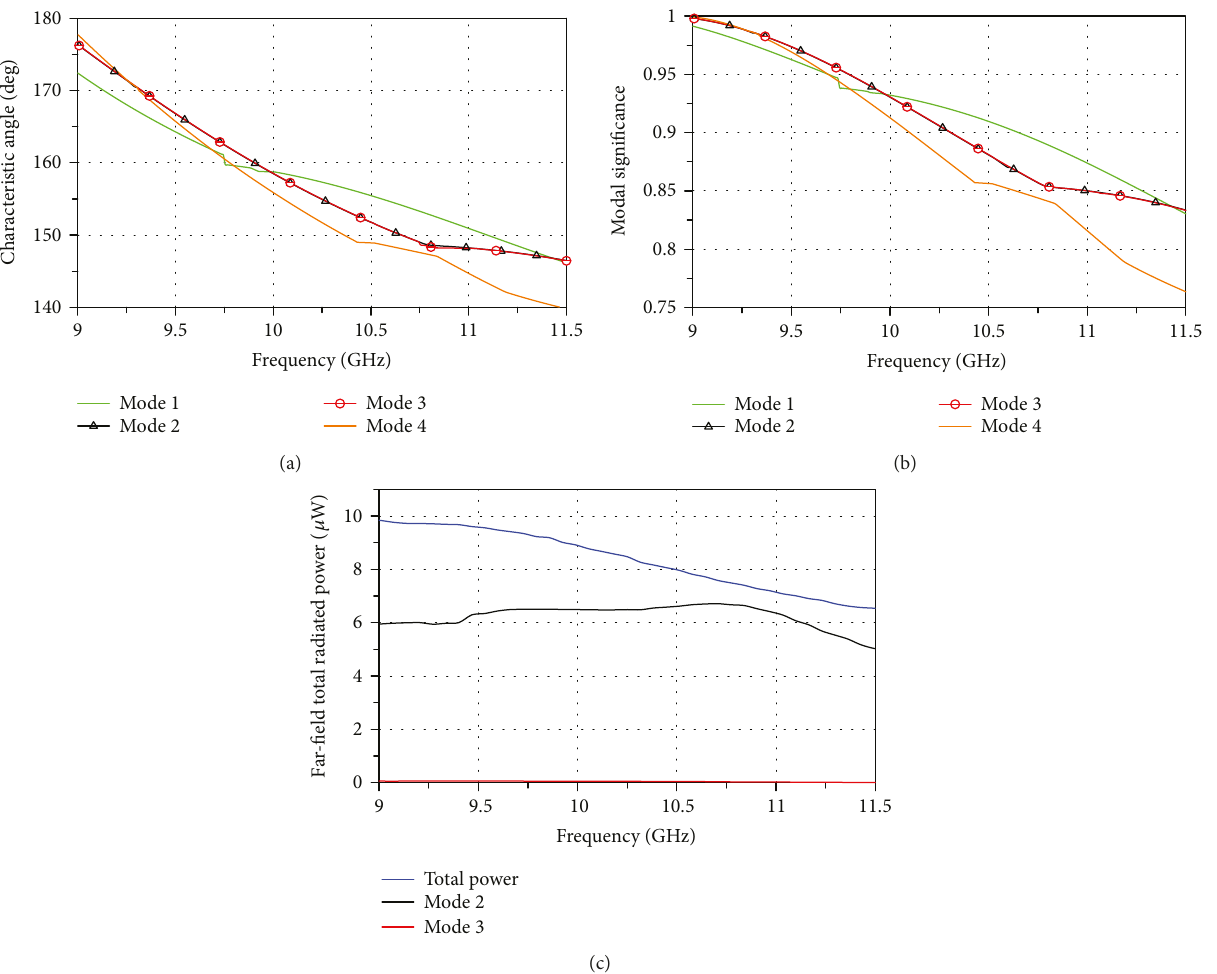
Figure 6: Modal parameters of the proposed lens: (a) characteristic angle, (b) modal signi fi cance, and (c) contribution of each mode to the total radiated power (including also the power of high-order modes).